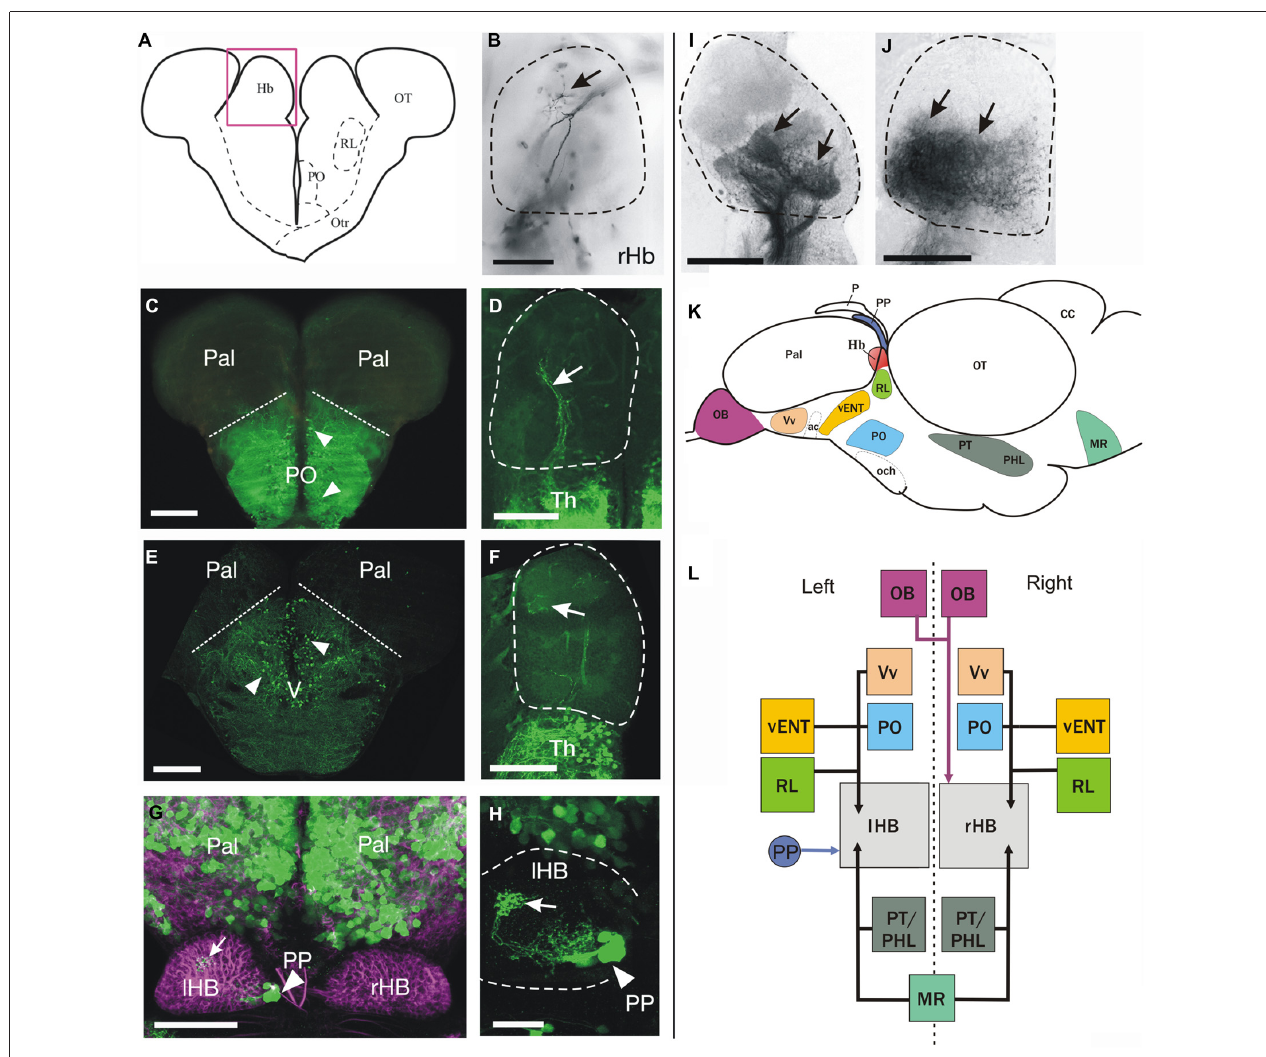
FIGURE 3 | Cell populations projecting to the habenula identified by anterograde DiI labeling and/or transgene expression. (A–J) Schematic of a transverse section on the brain at the level of the habenulae (A) . The pink box approximates the area shown in (B,D,F,I,J) . Images are from transverse sections (B–F,I–J) or dorsal views with anterior to the top (G,H) of zebrafish brains. Dotted lines in (B,D,F,H–J) mark the limits of the habenula. Images are of adult brains unless otherwise stated. (B) Labeled fibers (arrow) dorsally in the right habenula after DiI application in the olfactory bulb. (C) GFP+ neurons (arrowheads) in preoptic areas of a Tg(isl1:GFP) rw0 fish. Dotted lines mark the approximate limit between preoptic areas (ventral) and pallium (dorsal). (D) Sparse GFP+ fibers in the right habenula (arrow) of an adult Tg(isl1:GFP) rw0 fish. (E) GFP+ neurons (arrowheads) in the subpallium of a Tg(1.4dlx5a-dlx6a:GFP) ot1 fish. Dotted line marks the approximate pallial-subpallial boundary. (F) Very few GFP+ fibers (arrow) in the habenula of a Tg(1.4dlx5a-dlx6a:GFP) ot1 fish. (G) GFP expression (green) in 1 month old (1mpf) Et(gata2:GFP) bi105 juvenile zebrafish counter stained against tubulin (magenta) showing GFP+ neurons in the pallium and parapineal (PP, arrowhead). Note that the parapineal sends axons that terminate in the left habenula (arrow). Image is a dorsal view, anterior to the top. (H) High magnification image of the left habenula shown in G (after subtracting tubulin channel) showing that GFP+ fibers in the habenula (arrow) originate from the parapineal (PP, arrowhead). (I) Confocal image of the habenula showing labeled fibers (arrows) in the habenula after DiI application to the rostral vENT. Although more intense labeling is observed in ventral regions of the habenula, precise habenula subnuclei could be delineated using this method. (J) Labeled fibers (arrows) in the ventral half of the habenula after DiI application to the posterior hypothalamic lobe. (K,L) Schematics showing a summary of the main afferent areas to the habenula ( K : outline of the brain in lateral view, L : boxes diagram). (K) The brain nuclei that project to the habenula are shown as colored areas. (L) Boxes represent main nuclei projecting to the habenula, while arrows represent projections. Asymmetric projection from the parapineal (PP) to left habenula (lHB) is shown with a blue arrow. Asymmetric projection from mitral cells of the olfactory bulbs (OB) to right habenula (rHB) is shown with a pink arrow. All other afferent areas that seem to innervate both left and right habenula are represented with black arrows. Scale bars: 150 µ m in (B–F,I–J) ; 100 µ m in (G) , 50 µ m in (H)